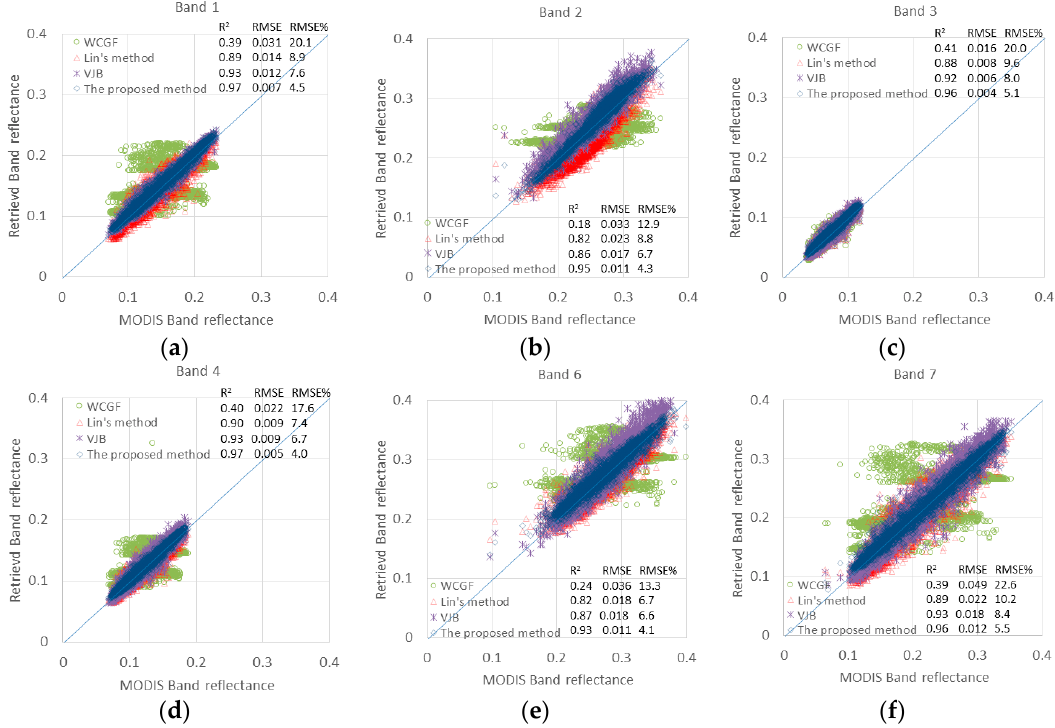
Figure 8. The 2D scattering plots show the precision statistics between the spectral reflectance for MODIS bands and the retrieved spectral reflectance for MODIS bands using the four methods in the simulated cloud area from Figure 6b: ( a – f ) MODIS bands 1, 2, 3, 4, 6, and 7 (Band 5 is not used because of bad stripe).